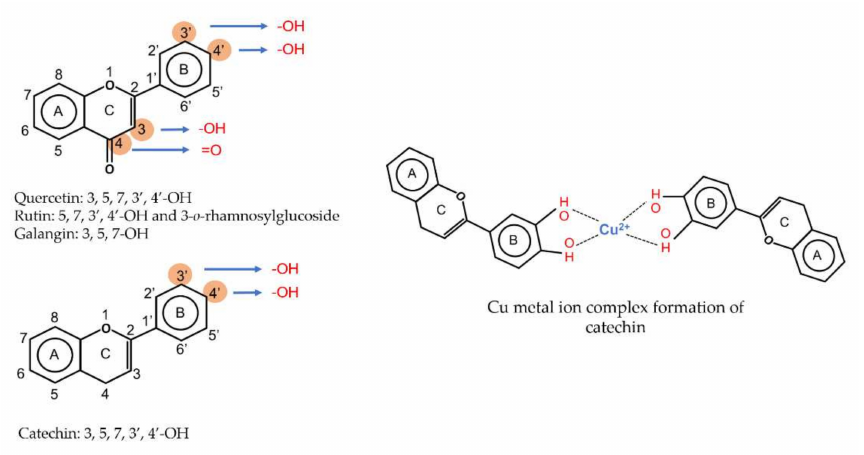
Figure 1. Metal ion complexation from flavonoids. Flavonoids that have ability to chelate metal ions (Fe 3+ , Cu 2+ ) at the sites include 3 (cid:48) ,4 (cid:48) -dihydroxy group on the B ring (rutin and catechin) and 3-hydroxy and 4-oxo groups on the C ring (galangin and